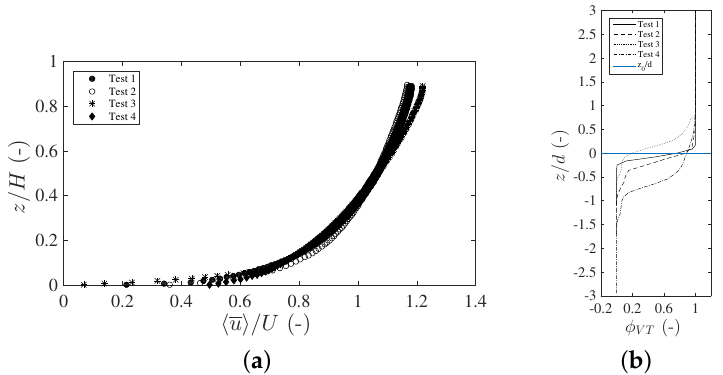
Figure 3. Double-averaged longitudinal velocity profiles ( a ) and space–time porosity φ VT ( x i , t ) ( b ). The reference zero in plot ( a ) corresponds to the elevation of the particle crests (defined in the text). H is the flow depth measured from this zero. The reference zero in plot ( b ) corresponds to the initial elevation of the particle crests for Test 1 (no bedload